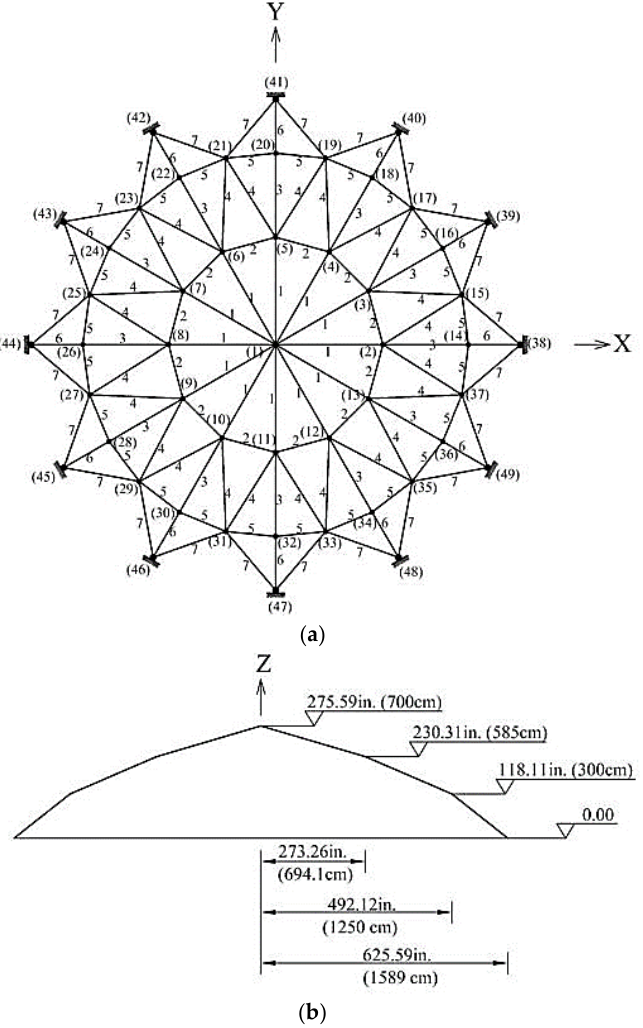
Figure 5. Diagram of a 120-bar dome truss: ( a ) plan view, ( b ) section view.